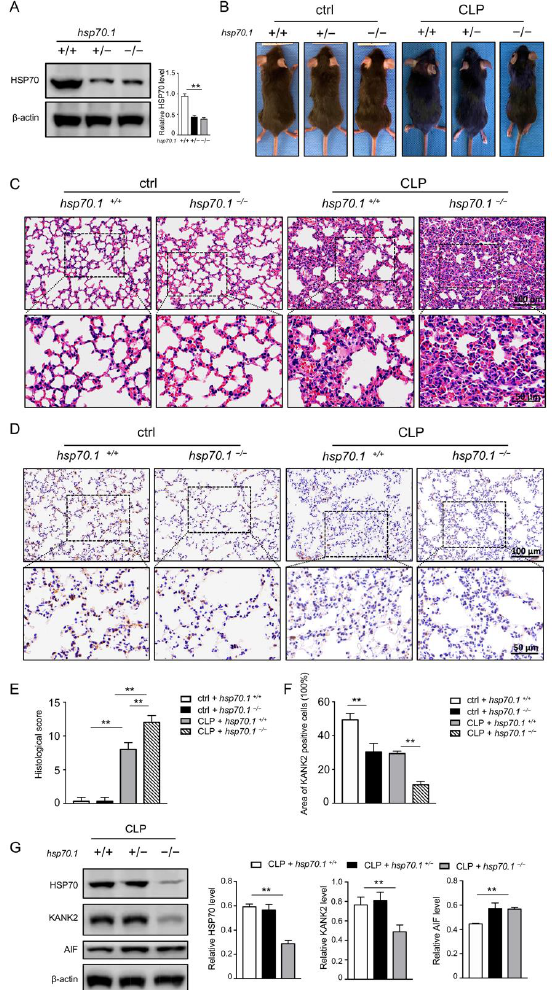
Figure 6. Interaction of HSP70 and KANK2 in hsp70.1 − / − mice. hsp70.1 +/+ , hsp70.1 +/ − , and hsp70.1 − / − mice were bred and the lung tissues were collected. The levels of HSP70 were measured in mice lung